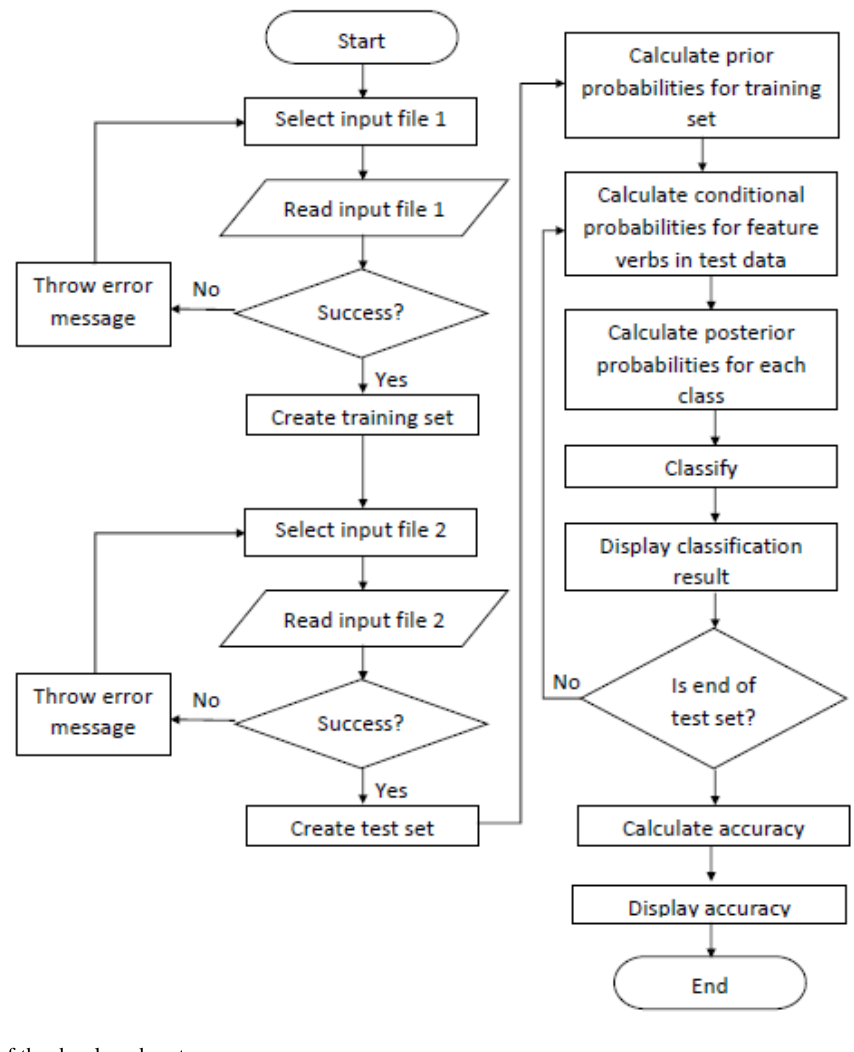
Figure 7. Workflow of the developed